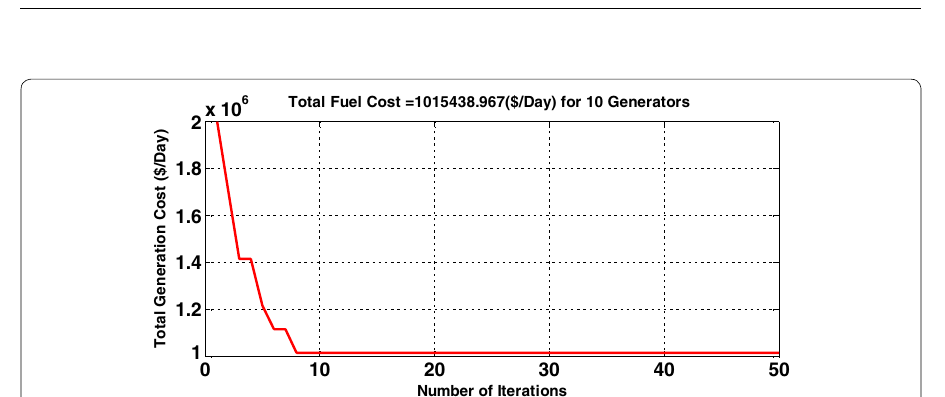
Fig. 7 Convergence graph of test case